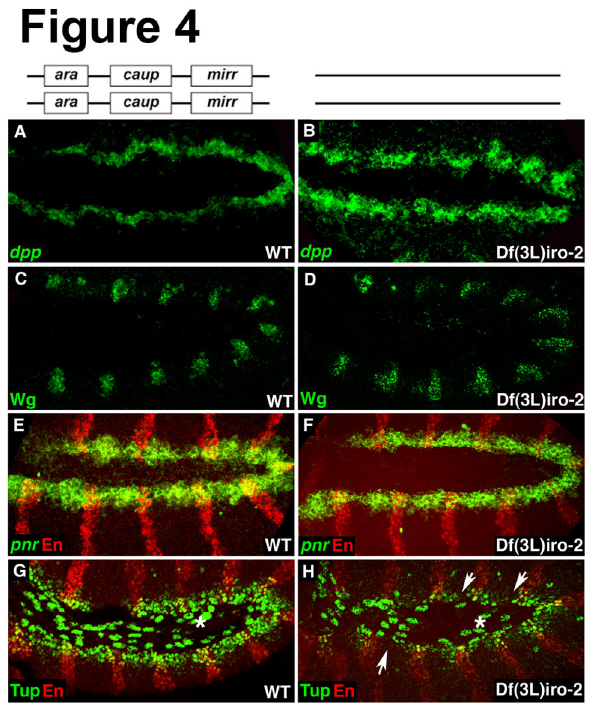
Figure 4. Wg and dpp expression in the ectoderm is independent of Iro-C . (A-D) Expression of the two crucial cardiac growth factors secreted from the ectoderm, dpp (A, B) and Wg (C, D) is unaffected in Iro-C mutants at early stages. (E, F) Ectodermal pnr mRNA expression does not depend on Iro-C . (G, H) Iro-C is required for ectodermal Tup expression (arrows). Asterisks in G and H indicate Tup expression in the amnioserosa. Images in E-H are confocal images of double stainings using Engrailed (En) as a marker for the ectodermal